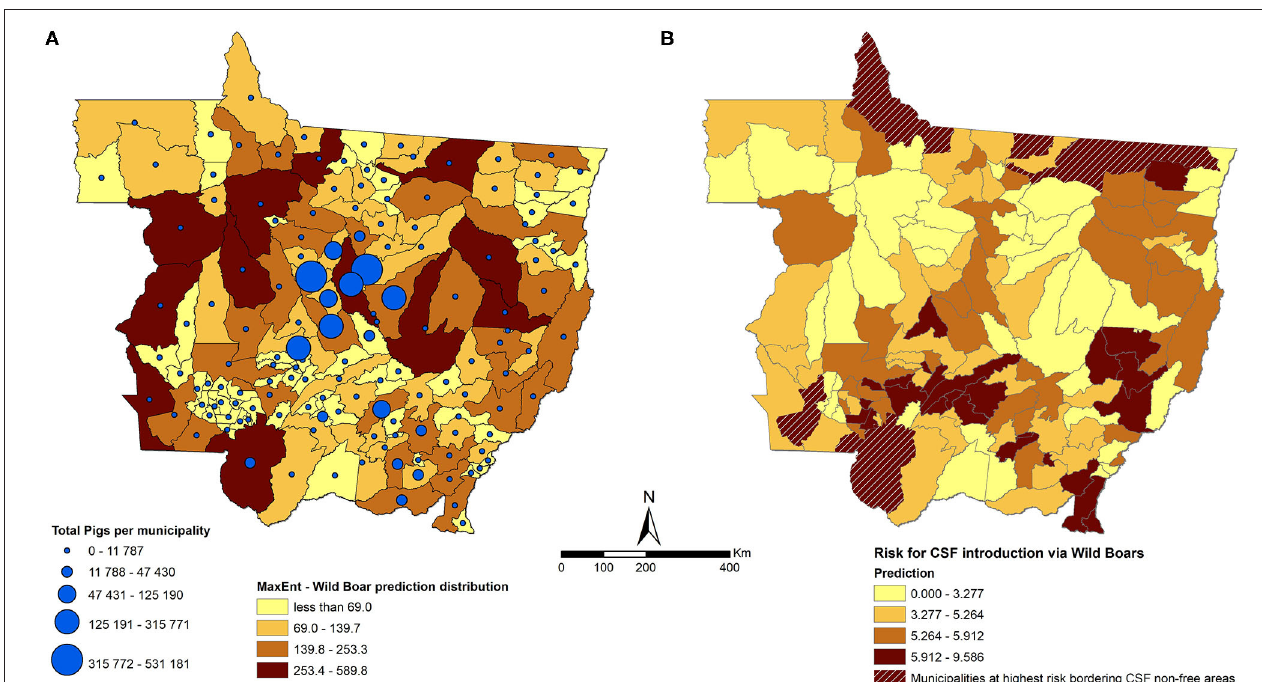
FIGURE 3 | (A) Distribution of wild boars predicted by a maximum entropy model aggregated at the municipality level in MT (the darker the shade of the polygon, the higher the predicted value) and municipality-level number of pigs (the larger the size of the blue dot, the larger the number of pigs). (B) Results of the model for risk scores of the introduction of CSF into MT through wild boar movement (Rbm) (the darker the polygon, the higher the risk). The hatched areas are the municipalities at highest risk bordering CSF non-free